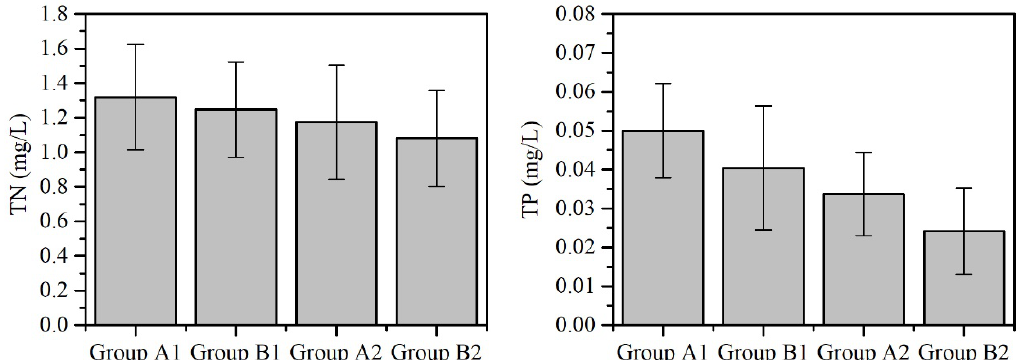
Figure A5. TN and TP concentrations in Groups A1, B1, A2 and B2. Group A1: the samples inside pens in Central Lake; Group A2: the samples inside pens in Eastern Lake; Group B1: the samples outside pens in Central Lake; Group B2: the samples outside pens in Eastern Lake.